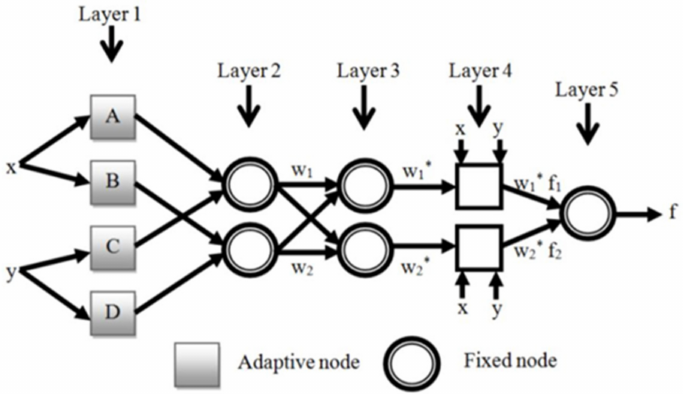
Figure 5. ANFIS basic architecture [43].